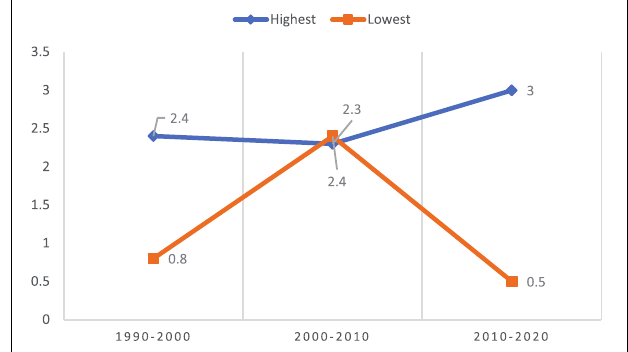
FIGURE 7 | Changing pattern of highest and lowest value of temperature in each